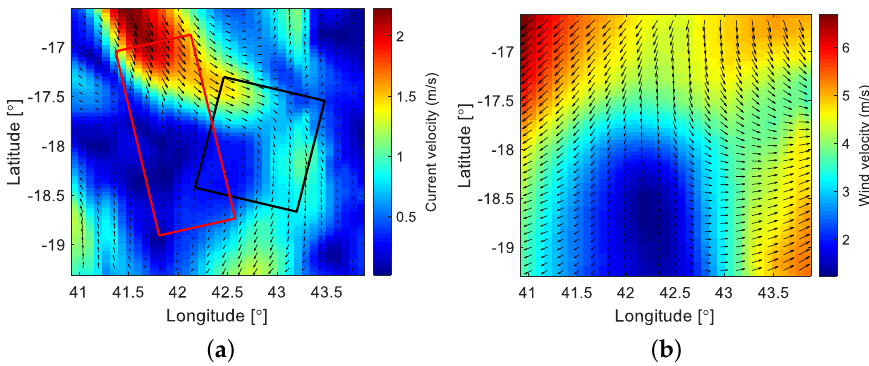
Figure 6. Simulation input sea-surface environment data. ( a ) current field and ( b ) wind field. The given current and wind data are input into the SAR ocean imaging model to